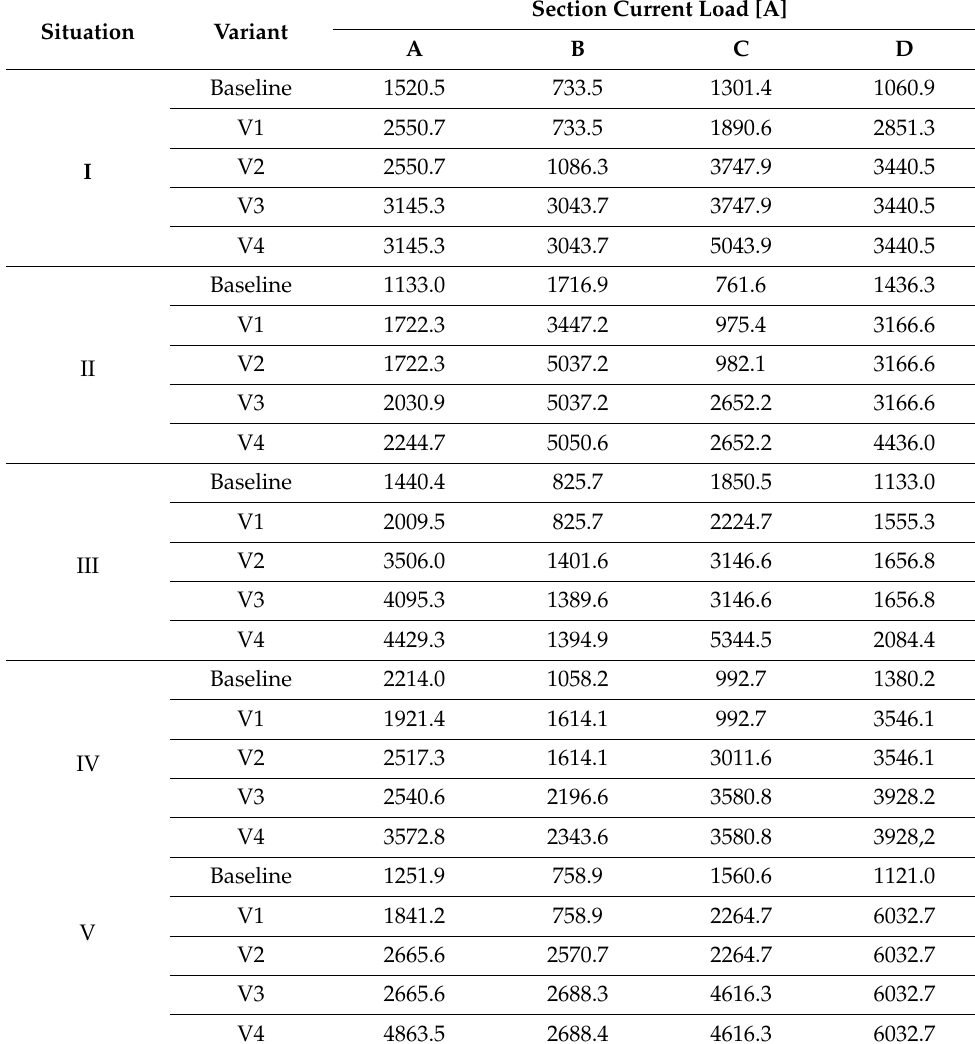
Table 3. Results of a